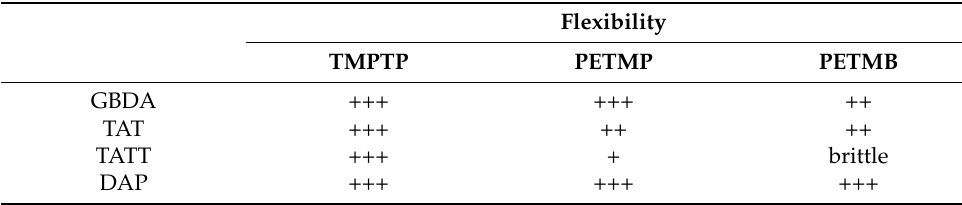
Table 3. Flexibility of the obtained